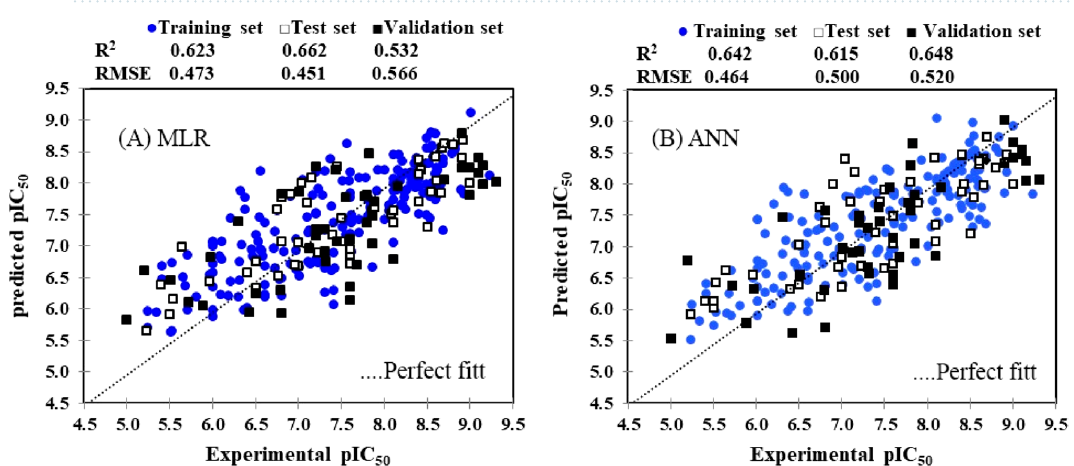
Figure 3. Scatter plots of the predicted versus experimental pIC 50 values for MLR ( A ) and ANN ( B ) models constructed on PI3Kγ inhibitory